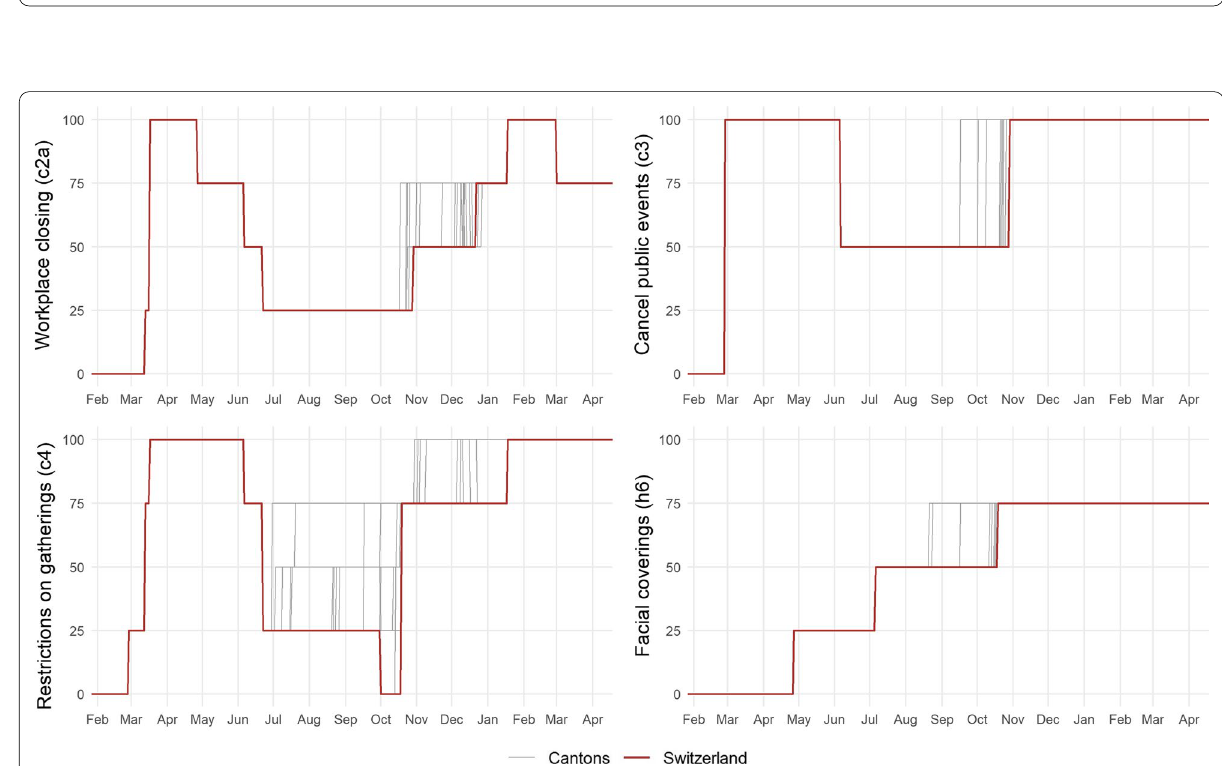
Fig. 3 Sub‑indicators of the KSI + with cantonal variation. The graph shows the sub‑indicators of the KOF Stringency‑Plus Index that exhibit cantonal variation. The respective sub‑indicator is denoted on the y ‑axis. Note that cantonal variation only starts at the end of June. The first lockdown was governed by federal